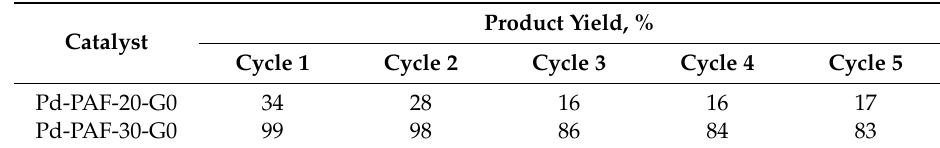
Table 8. Results of recyclability tests.